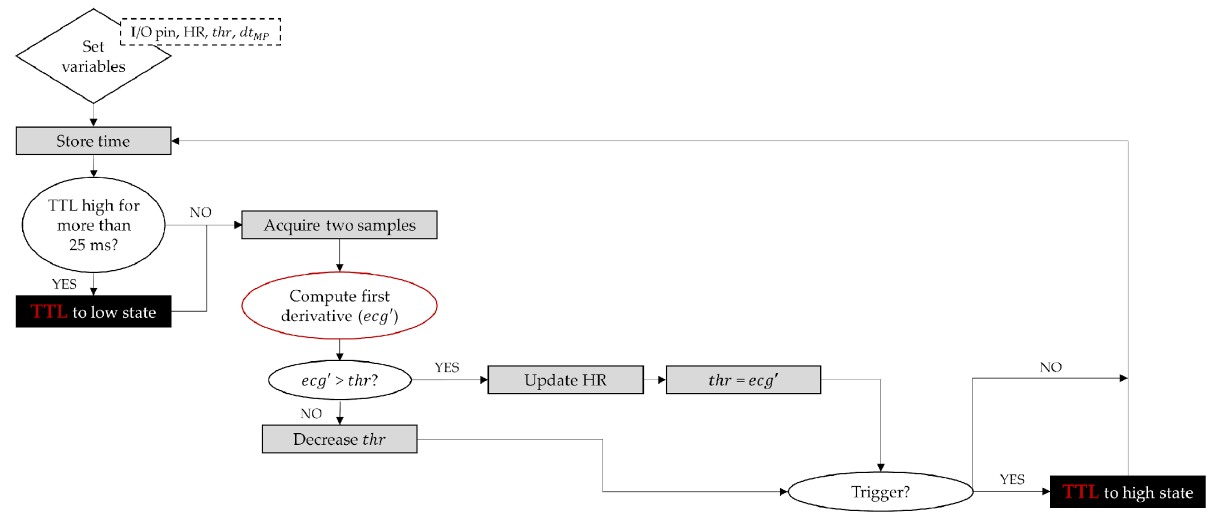
Figure 2. ECG to TTL conversion algorithm: ( 1 ) compute the first derivative, 𝑒𝑐𝑔’ , as the difference between two samples distanced ∆𝑡 ; ( 2 ) compare 𝑒𝑐𝑔’ to a predefined threshold, 𝑡ℎ𝑟 (black line); whenever 𝑒𝑐𝑔’ > 𝑡ℎ𝑟 (red circle), an R-wave is detected; ( 3 ) wait 𝑇 − 𝑑𝑡 (cid:3014)(cid:3017) seconds and set a high TTL state (red line); ( 4 ) after 25 𝑚𝑠 , set the TTL to low and return Figure 3. ECG to TTL algorithm diagram. to step 1.